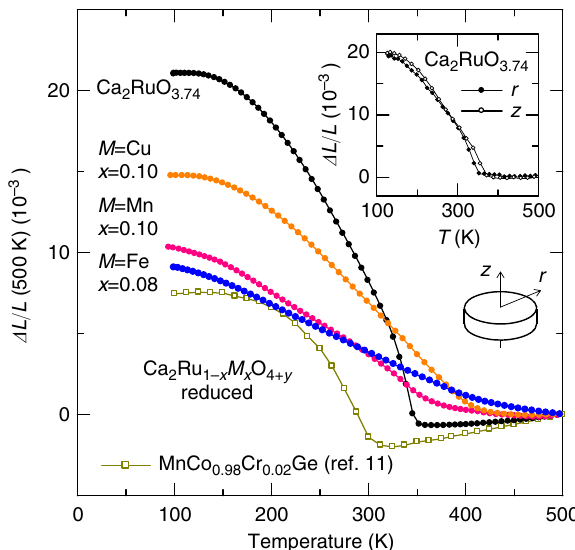
Figure 1 | Linear thermal expansion D L/L of reduced layered